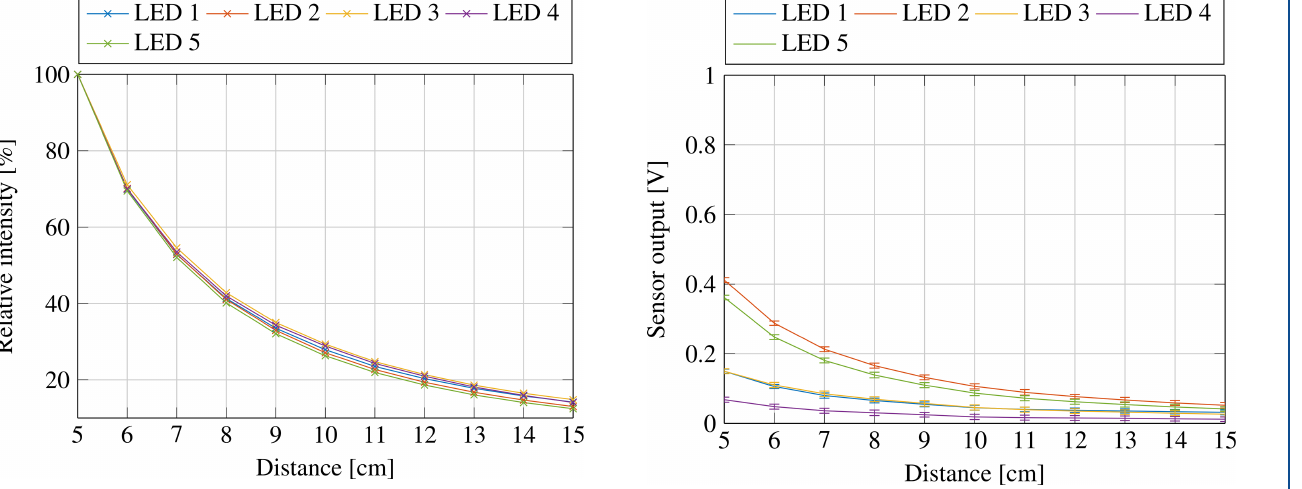
Figure 7. Relative intensity decrease at distances of 5 to 15cm with white tile surface without water.